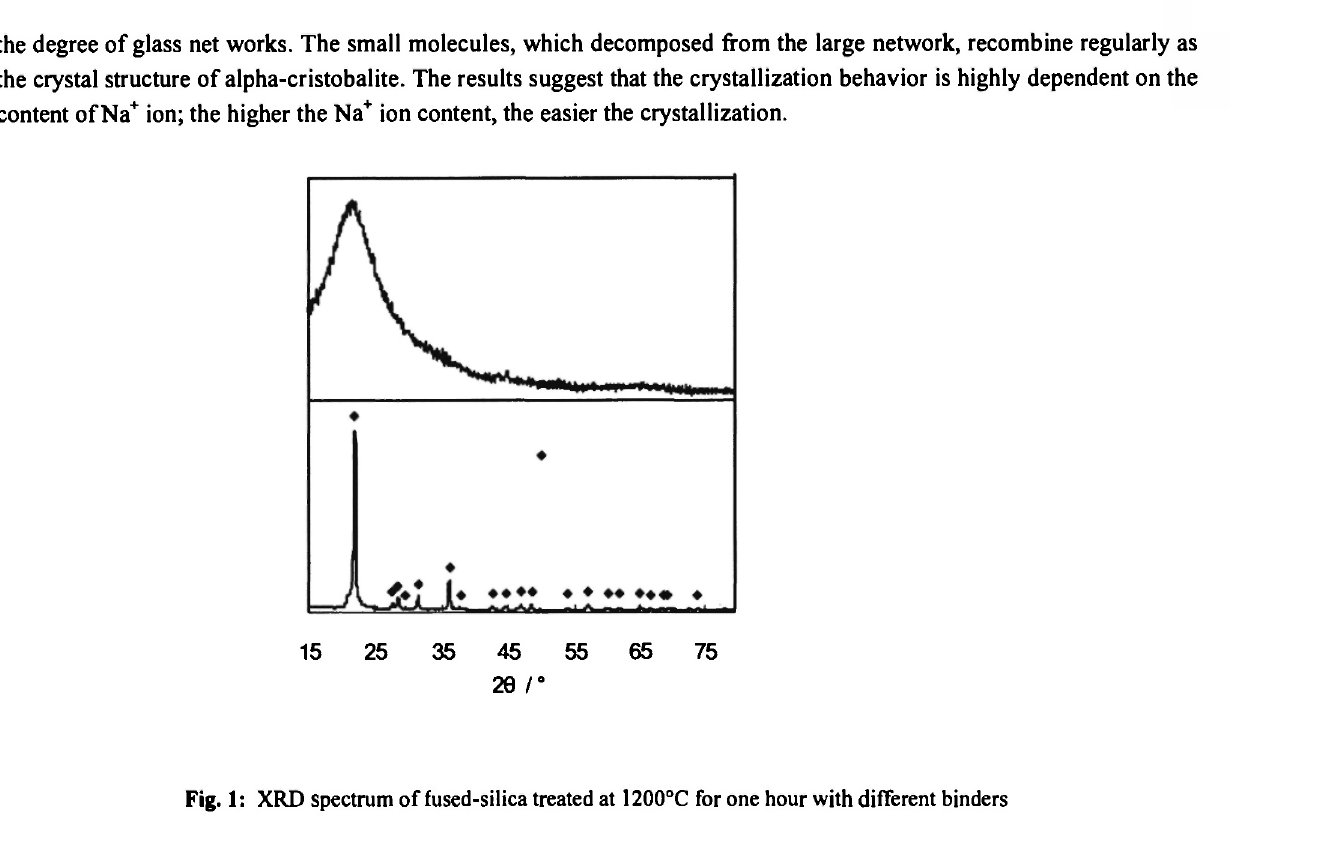
Fig. 1: XRD spectrum of fused-silica treated at 1200°C for one hour with different binders